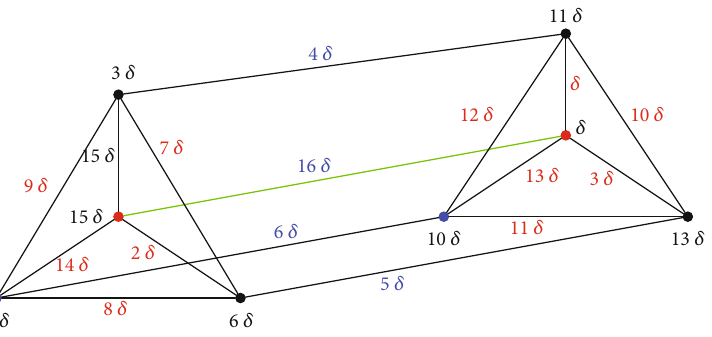
Figure 11: An edge δ − graceful labeling of the graph P ð W